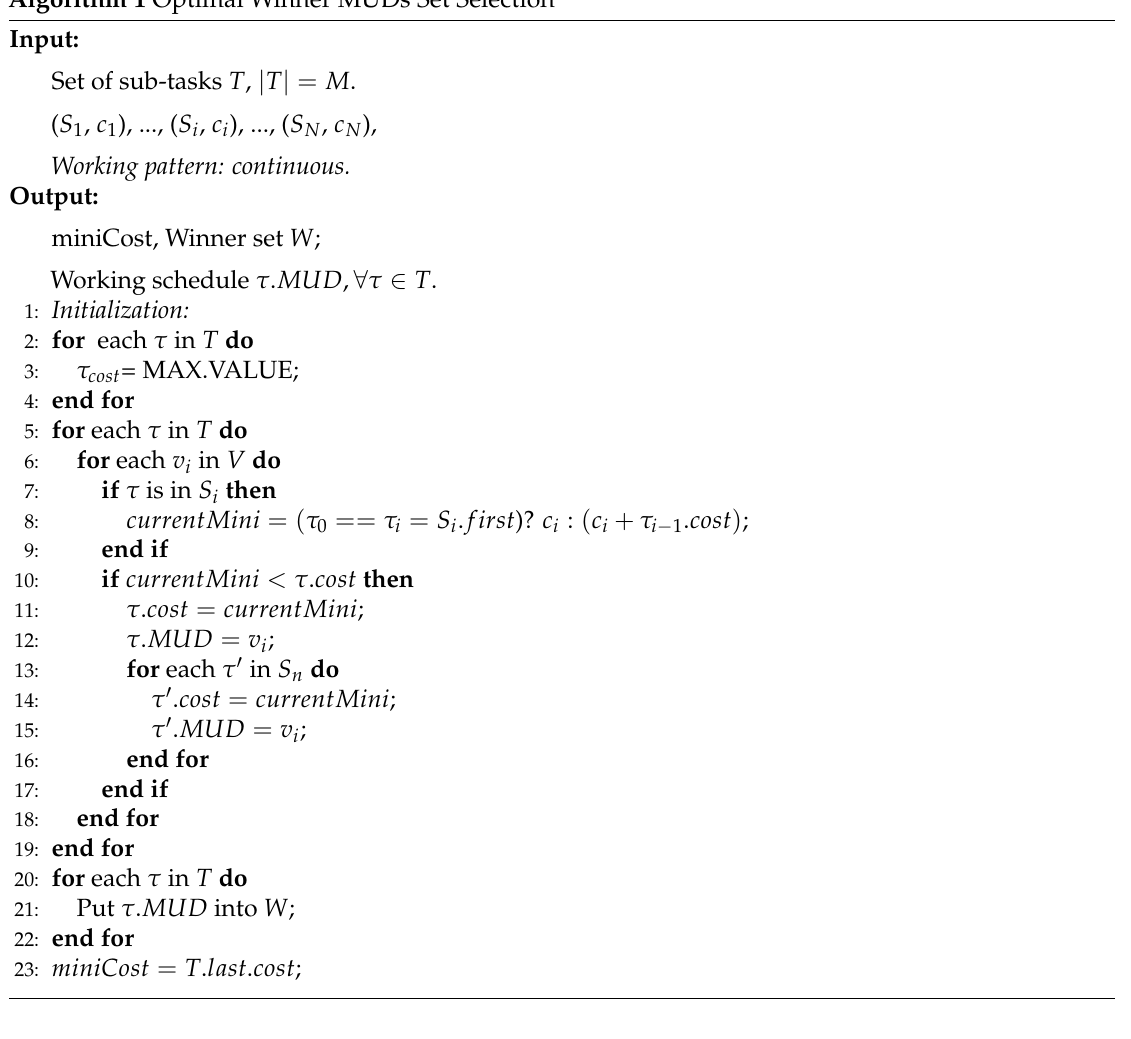
Algorithm 1 Optimal Winner MUDs Set